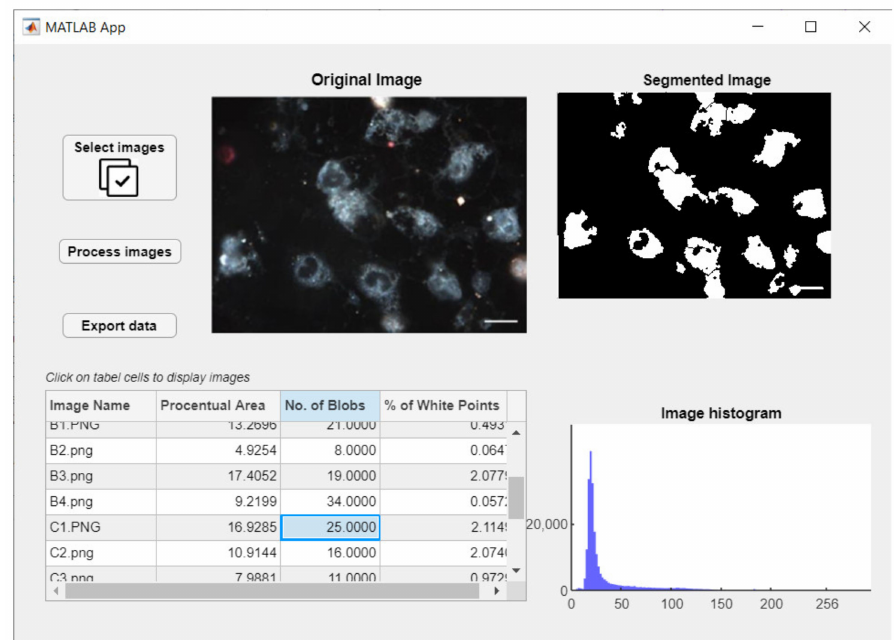
Figure 16. Application runtime